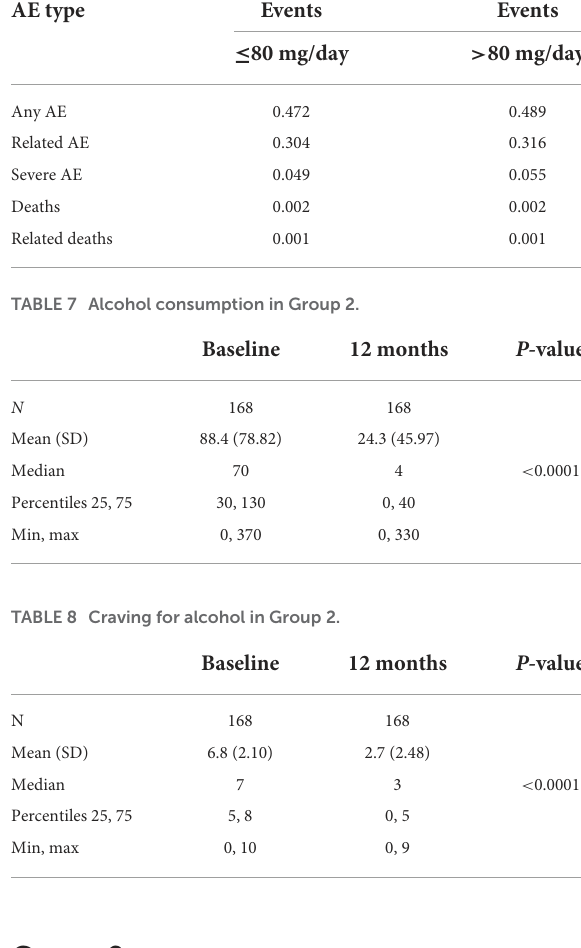
TABLE 5A Percentage of subjects with null or low-risk alcohol consumption for the last recorded dose.